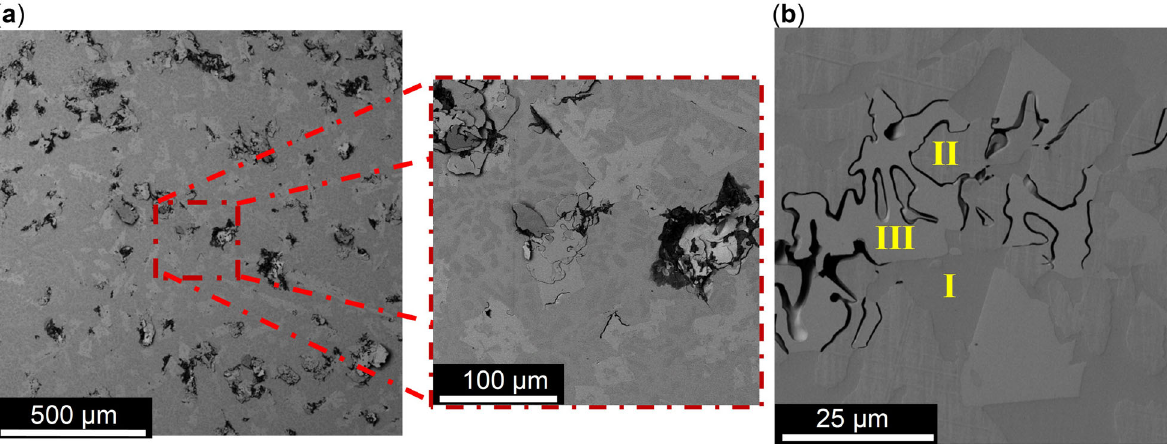
Fig. 8 BSE-SEM images of the AlFeMnSi alloy post + 400 mV SCE potentiostatic conditioning in 0.6 M NaCl. BSE-SEM images (5 kV accelerating voltage) of the AlFeMnSi alloy after a 10 min and b 30 s of potentiostatic conditioning at + 400 mV SCE in 0.6 M